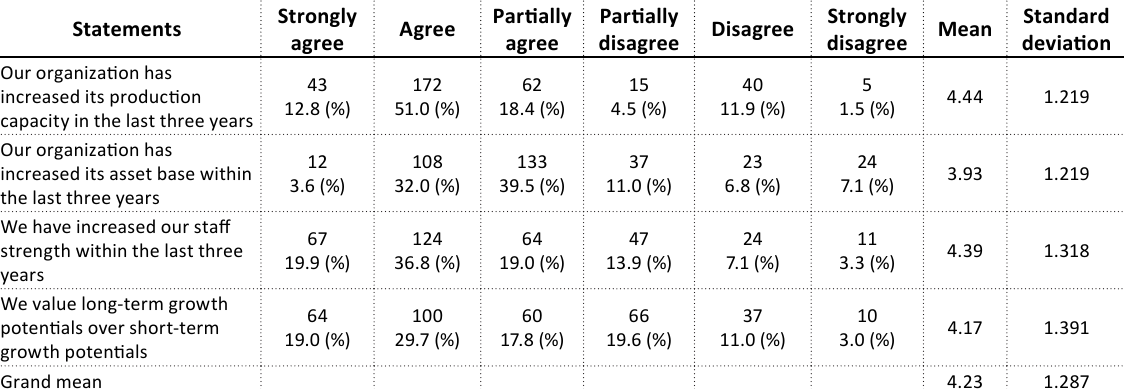
Table 2. Descriptive statistics of firm growth